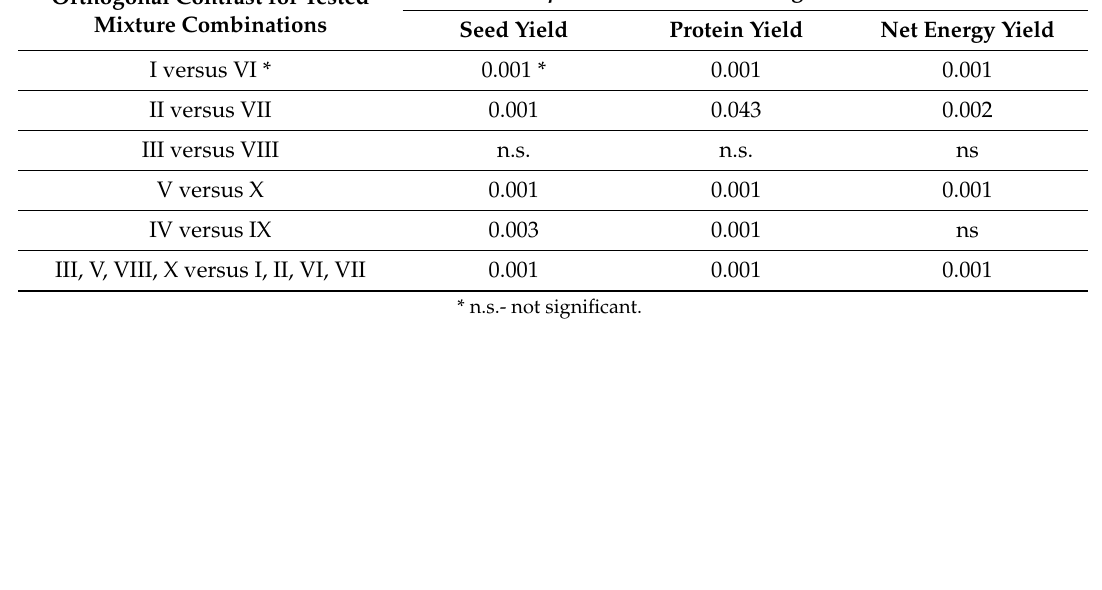
Table 7. Orthogonal contrast of selected treatments with covered barley depending on rate density Albic Luvisols. Orthogonal Contrast for